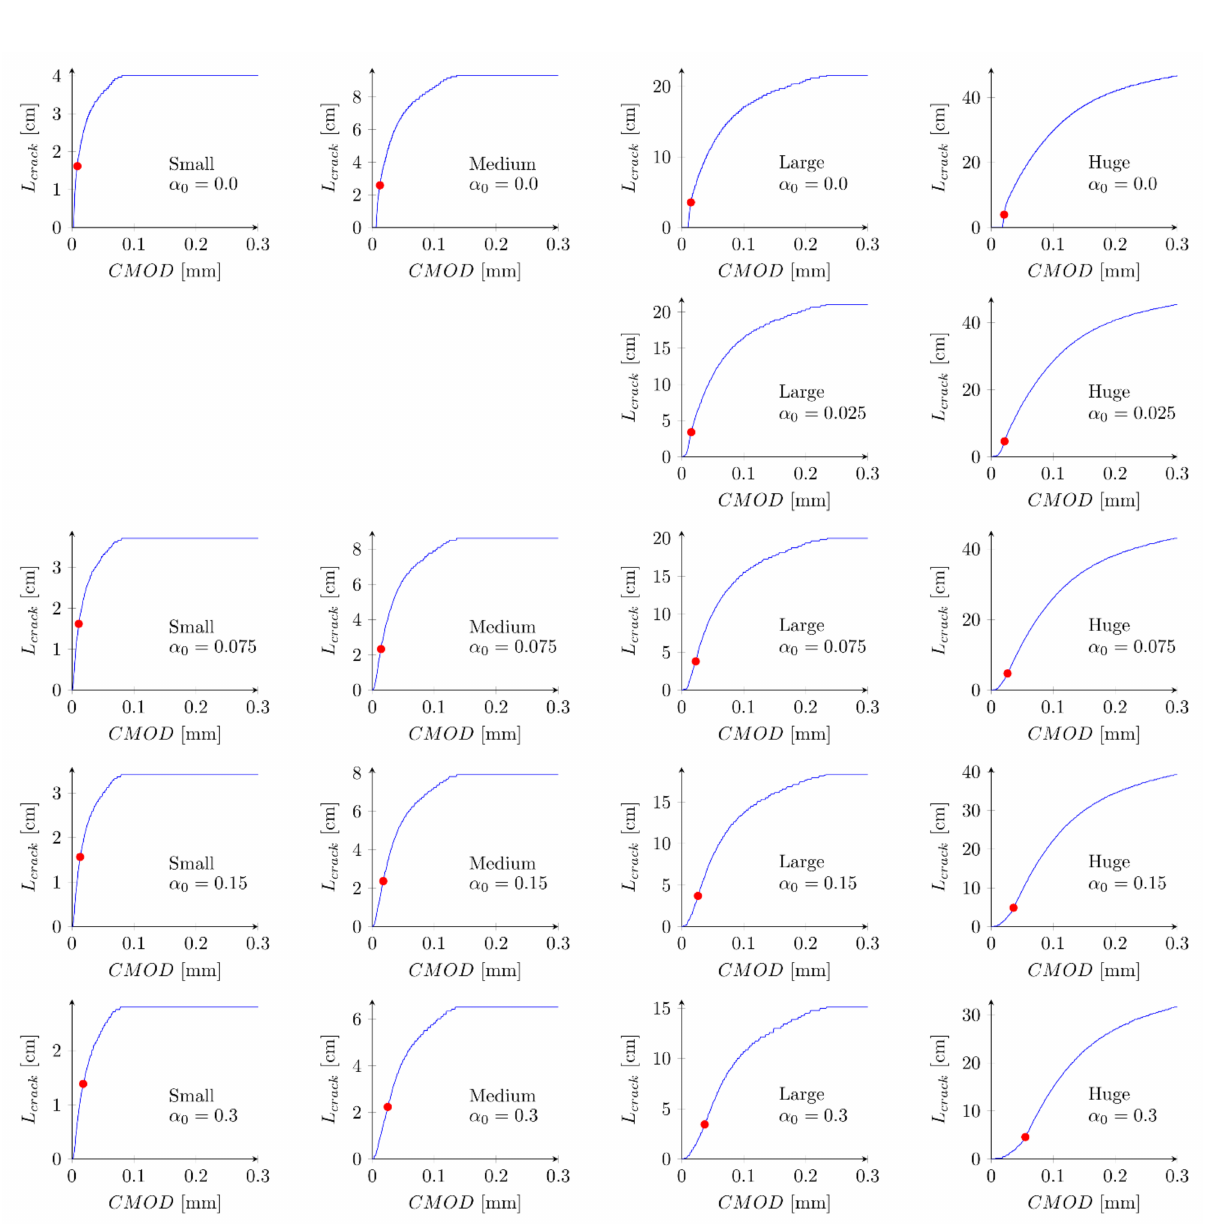
Figure 8. Evolution of crack lengths versus crack mouth opening displacement for set S1: f t = 4.8 MPa and G f = 48